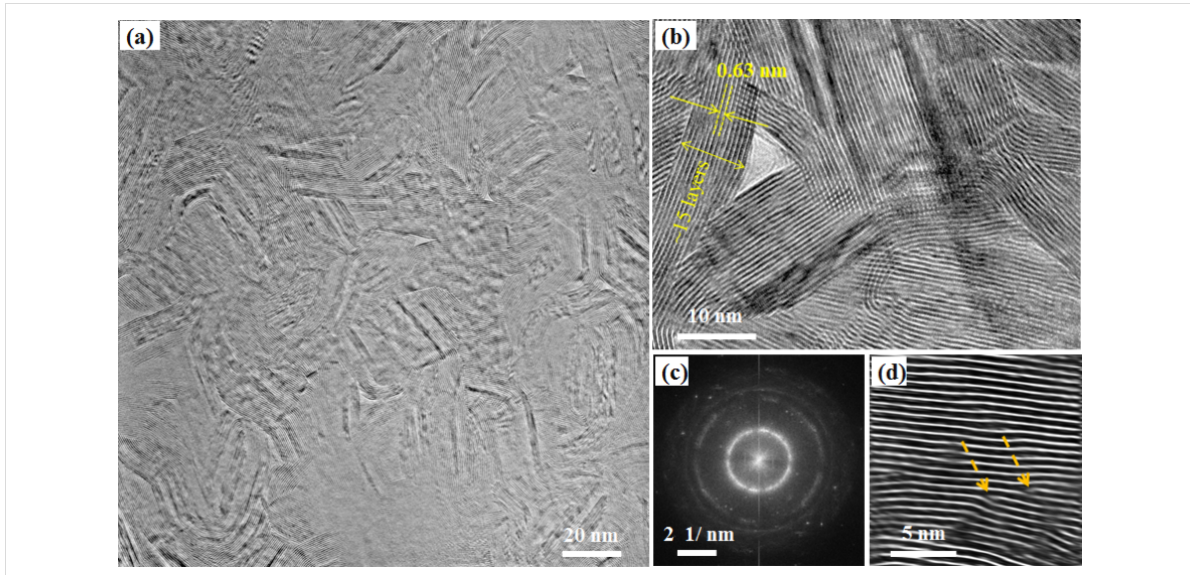
Figure 3: MoS 2 sample grown by double sulfurization of a 50 nm Mo film at 850 °C on SiO 2 /Si substrates: (a) Plane-view HRTEM image; (b) high- magnification TEM image; (c) FFT pattern of panel (a); (d) filtered HRTEM image indicating the presence of sheet stacking defects (indicated by orange arrows).